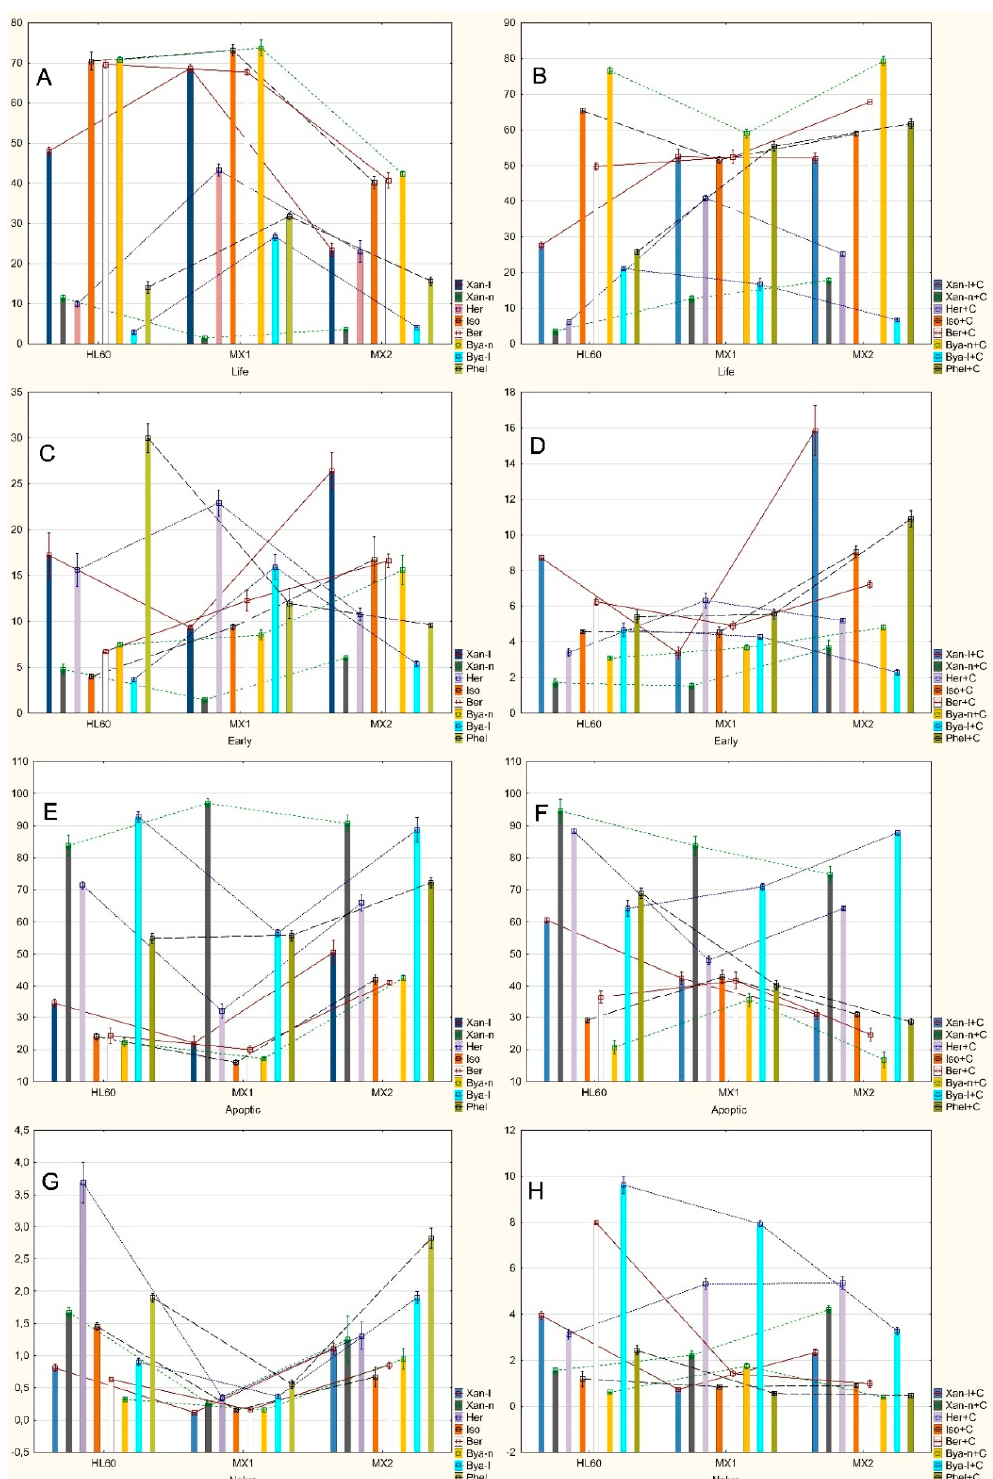
Figure 3. Statistically significant differences in the number of cells between the individual lines: HL60, HL60/MX1 and HL60/MX2 after exposure to the furanocoumarin compounds tested without mitoxantrone ( A —number of life cells; C —number of early apoptotic cells; E —number of late apoptotic cells; G —number of necrotic cells) or with mitoxantrone ( B —number of life cells; D —number of early apoptotic cells; F —number of late apoptotic cells; H —number of necrotic cells). There were no statistically significant differences in the number of necrotic cells between the HL60 and HL60/MX2 lines.